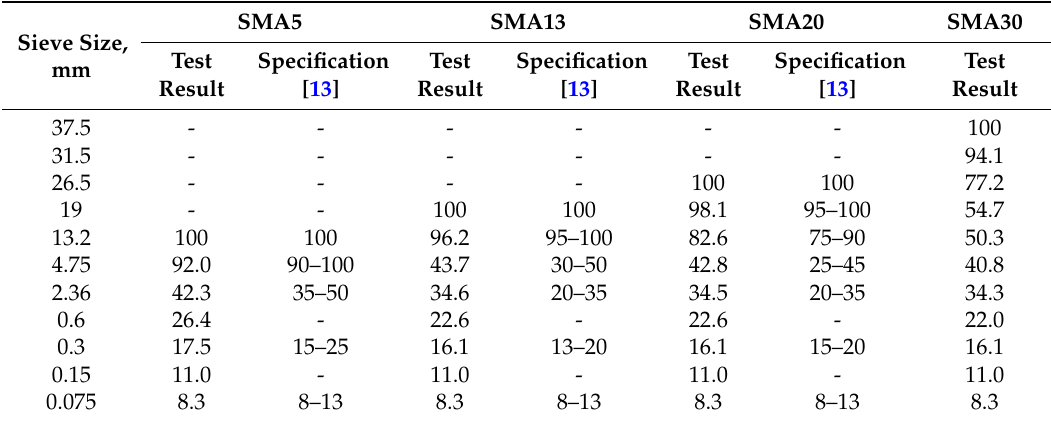
Table 5. Aggregate gradations of SMA mixtures (percent passing,